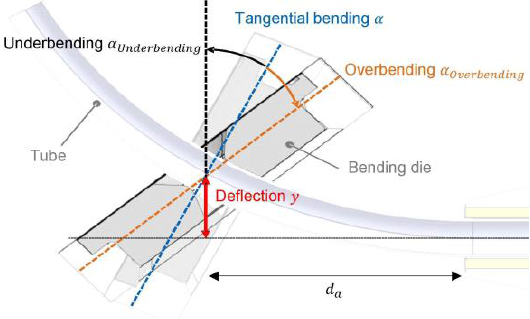
Figure 1. Tangential bending, Over- and Underbending based on foundations of [2].